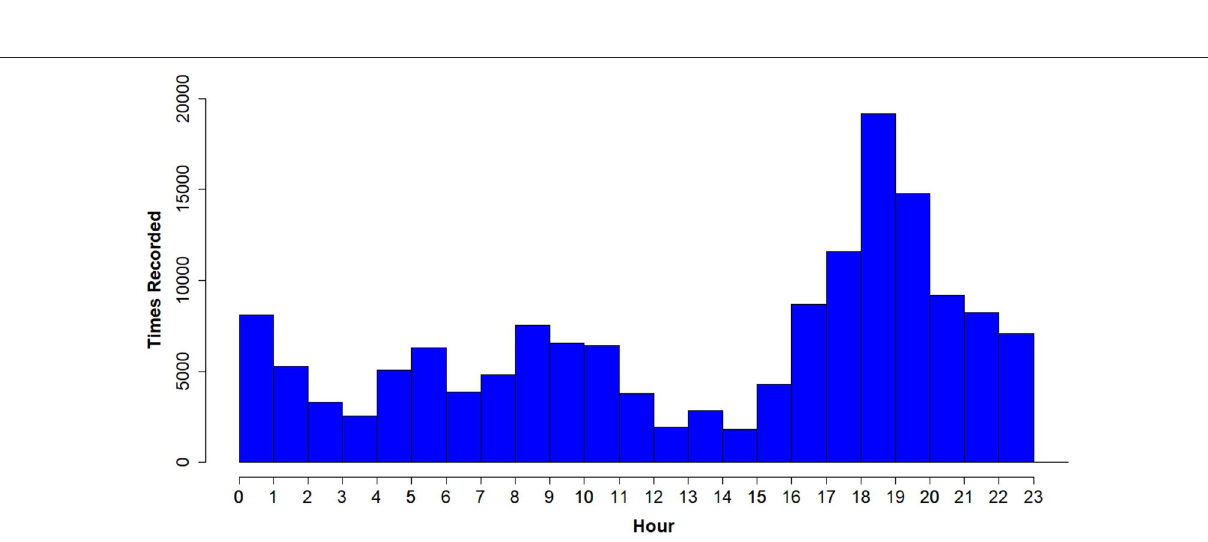
Frontiers in Ecology and Evolution | www.frontiersin.org